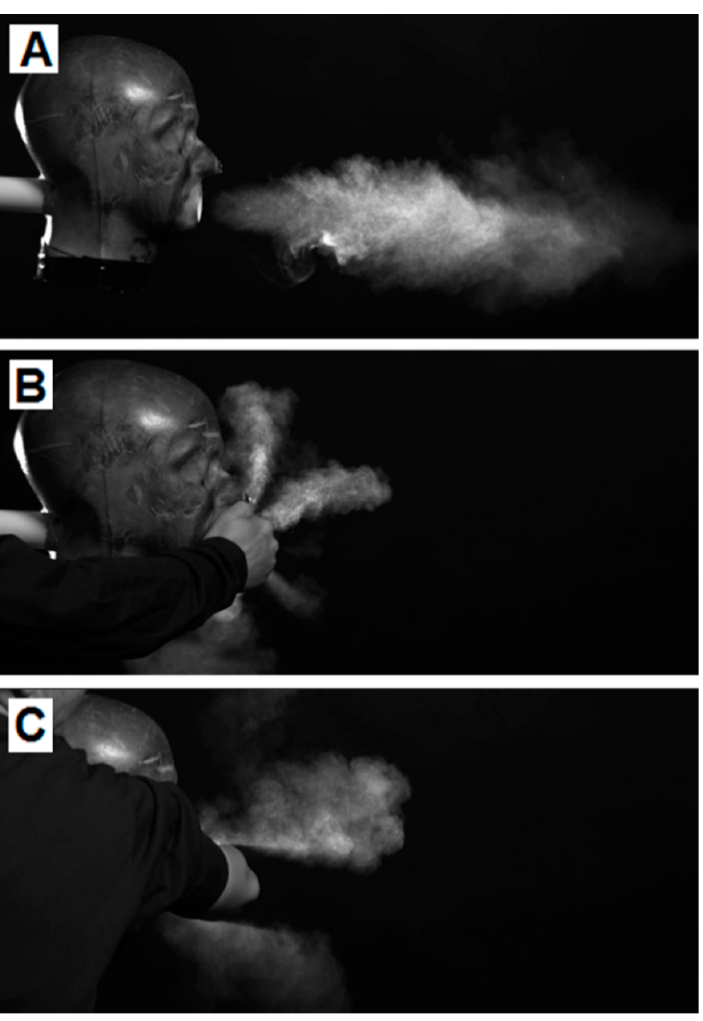
Figure 7. High-speed backlit photographs of test ( A ) the cough with no intervention, test ( B ) the cough with the hand over the mouth, test ( C ) the cough with a bare elbow. Visualisation tests undertaken with a balled fist showed that it did not deflect the cough like the cupped hand over the mouth, but resulted in wider and less elongated cloud dissemination, (Figure 8).